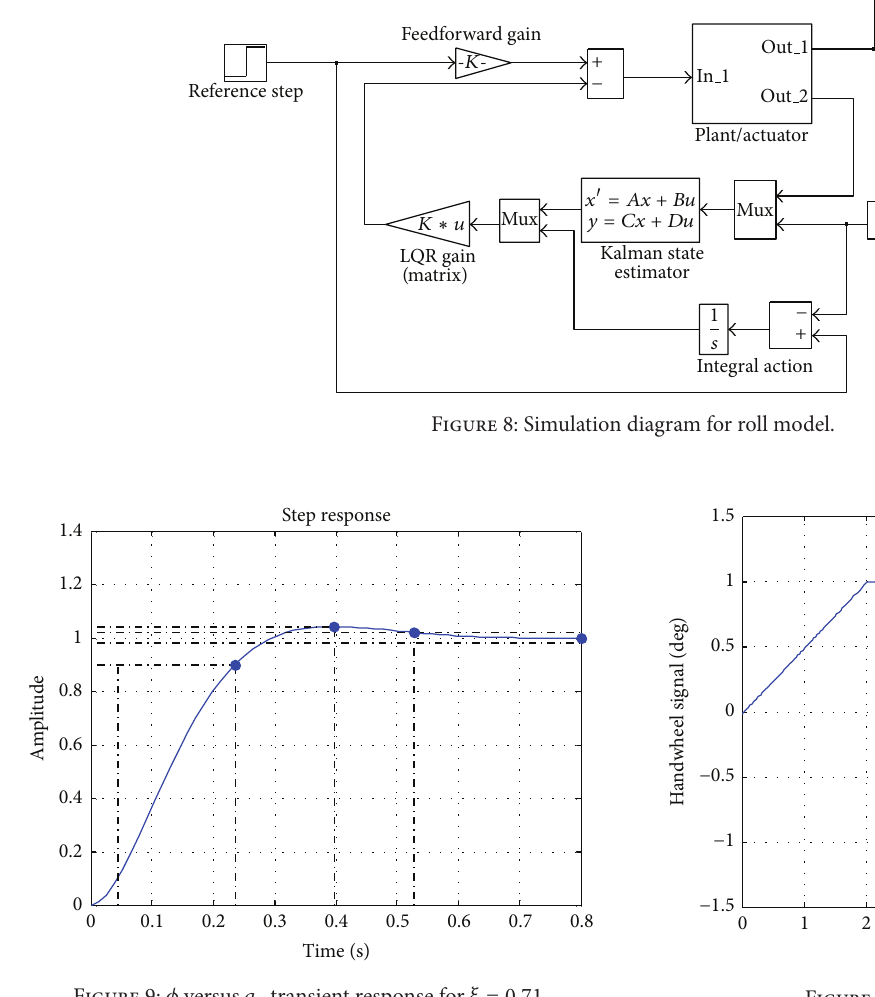
Figure 11: Fishhook 1a